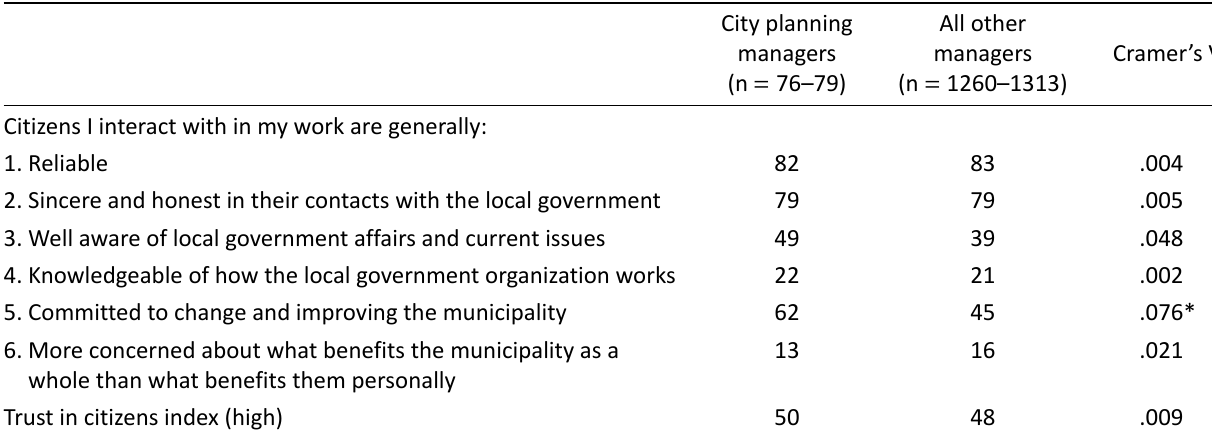
Table 2. Public managers’ trust in citizens (percentages that